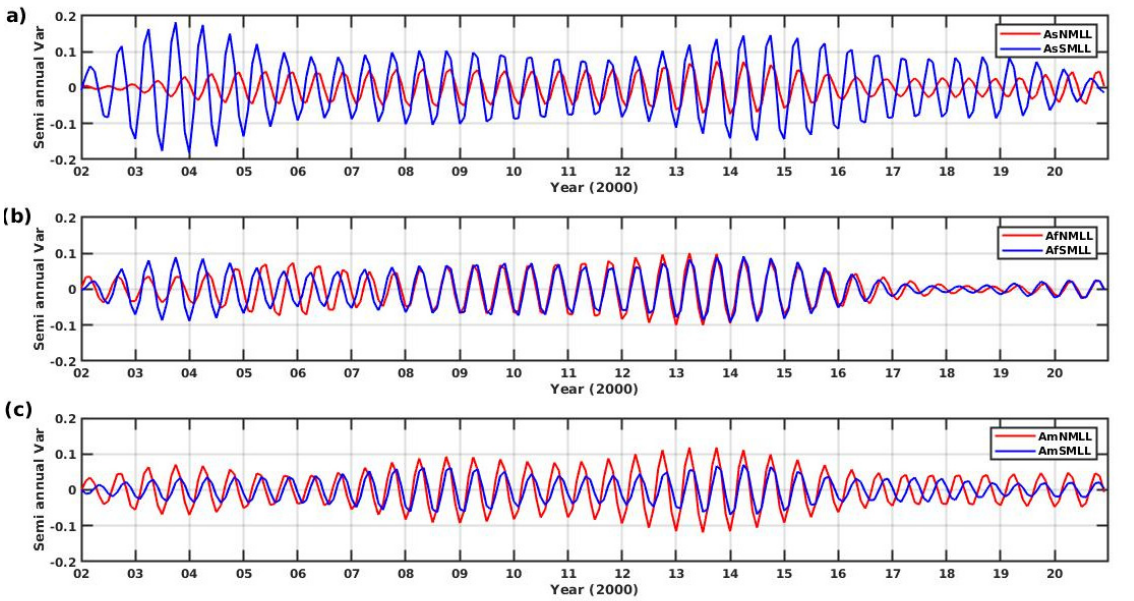
Figure 9. Similar to Figure 3b but for ( a ) Asian region, ( b ) African sector, and ( c ) American region.